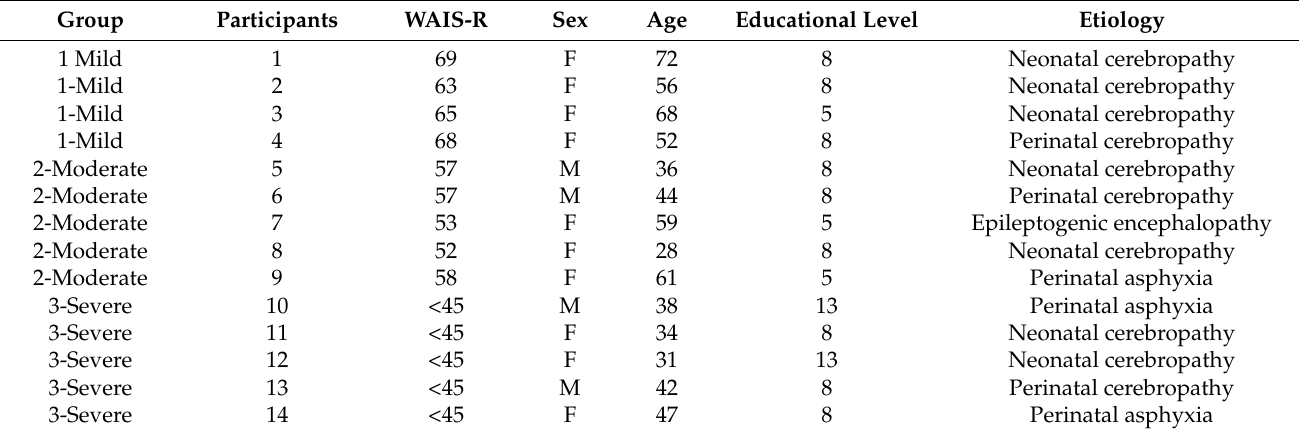
Table 1. Demographic and clinical data of the fourteen